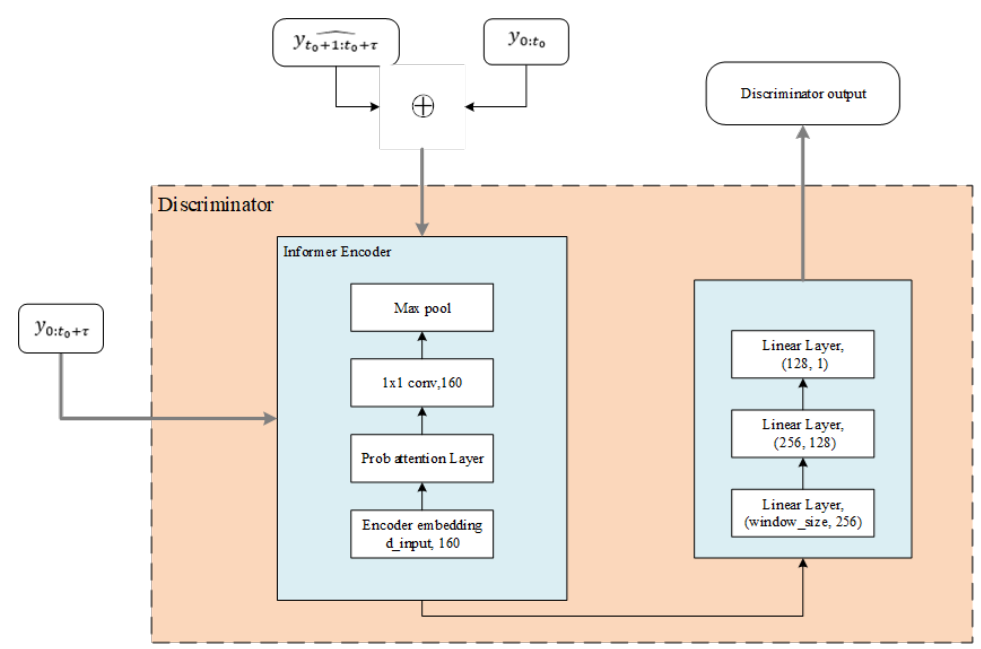
Figure 3. Discriminator